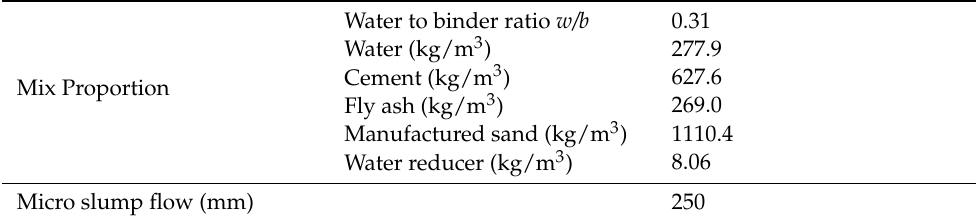
Table 1. Mix proportion and workability of